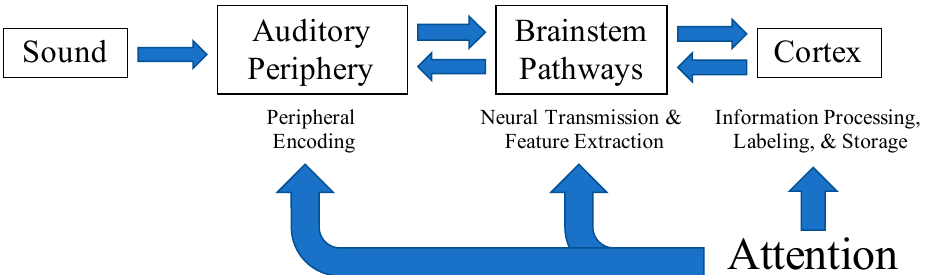
Figure 1. Attention is thought to influence the initial encoding and subsequent processing of auditory inputs across all levels of the auditory system. Adapted from Humes, 1996 with permission from the American Academy of Audiology.